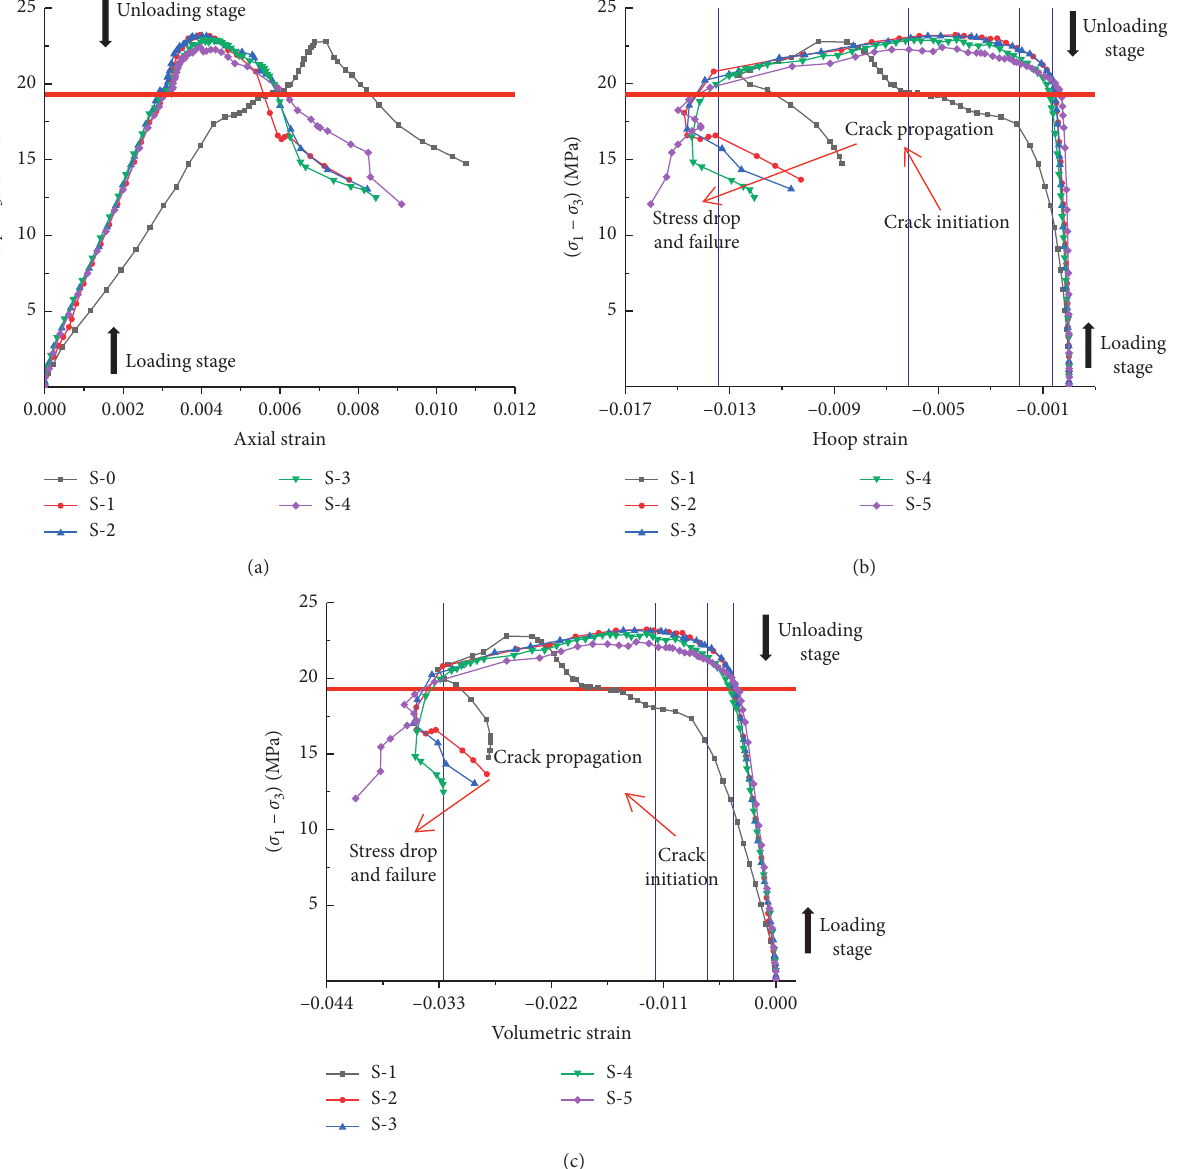
Figure 3: Stress–strain relationship curves for specimens used in this study. (a) Variation of ( σ . (c) Variation of ( σ ε 3